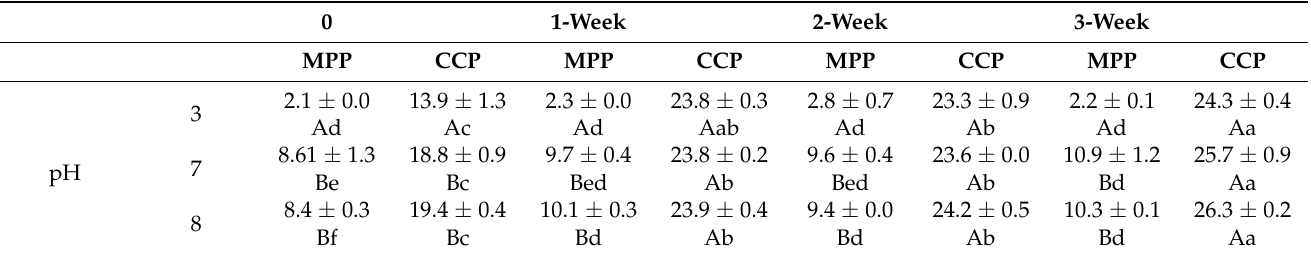
Table 5. The effect of different pH on the average particle size (D 4,3 , µ m) of pectin emulsion.